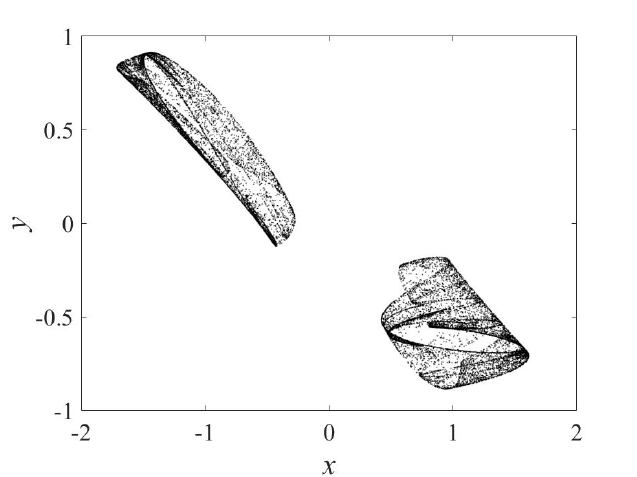
Figure 3. Chaos from the FPFM 1 map when x ( 0 ) = 1, y ( 0 ) = − 0.5.